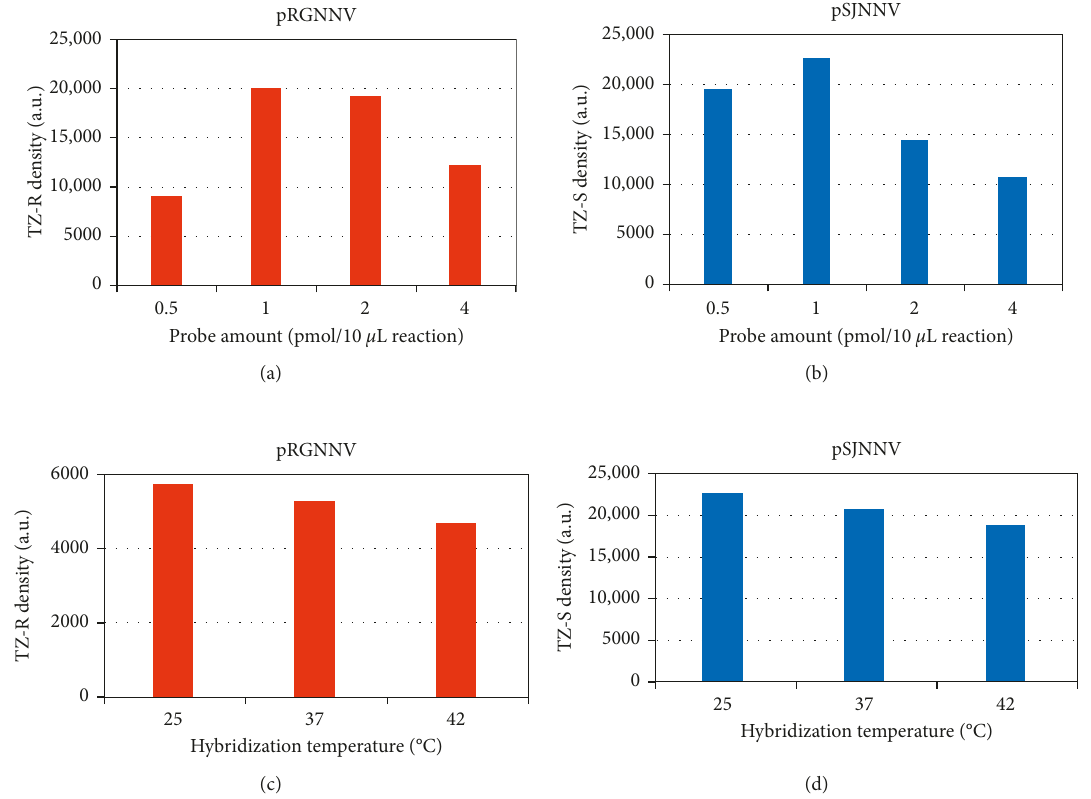
Figure 4: Dual lateral flow biosensor assay optimization studies. Representative lateral flow biosensors and signal intensity graphs for (a) oligonucleotide probe amount effect on plasmid pRGNNV amplification product hybridization mixture; (b) oligonucleotide probe amount effect on plasmid pSJNNV amplification product hybridization mixture; (c) hybridization temperature effect on the